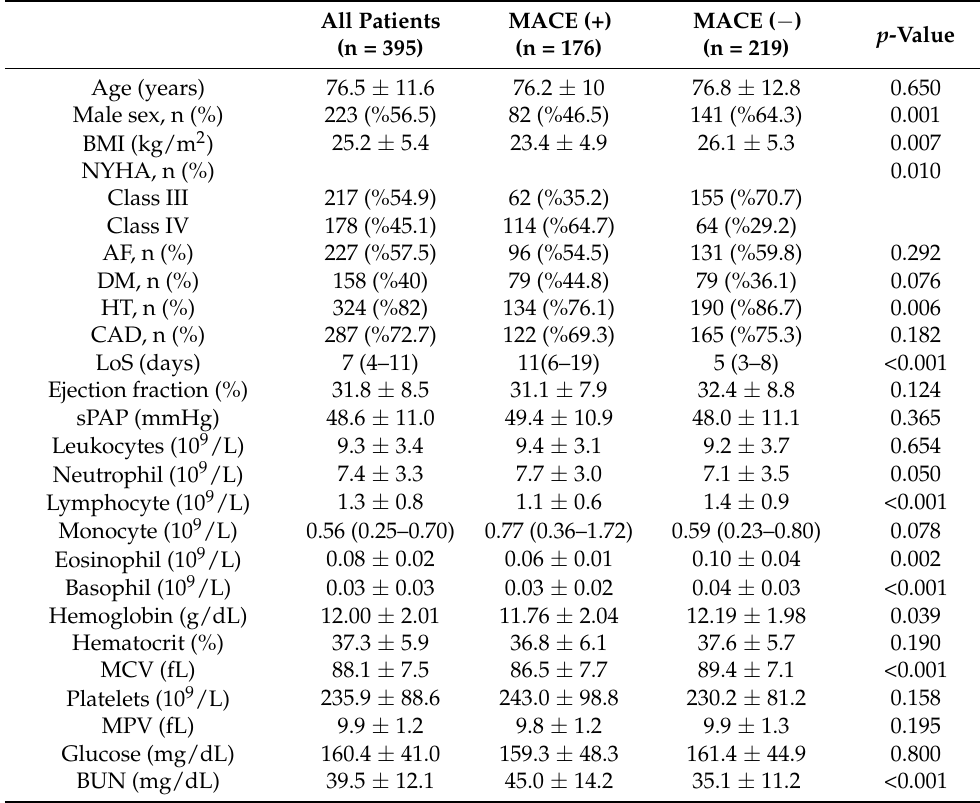
Table 1. Comparison of baseline demographic, clinical, laboratory and echocardiographic data of all study patients, MACE (+) and MACE ( − ) patient